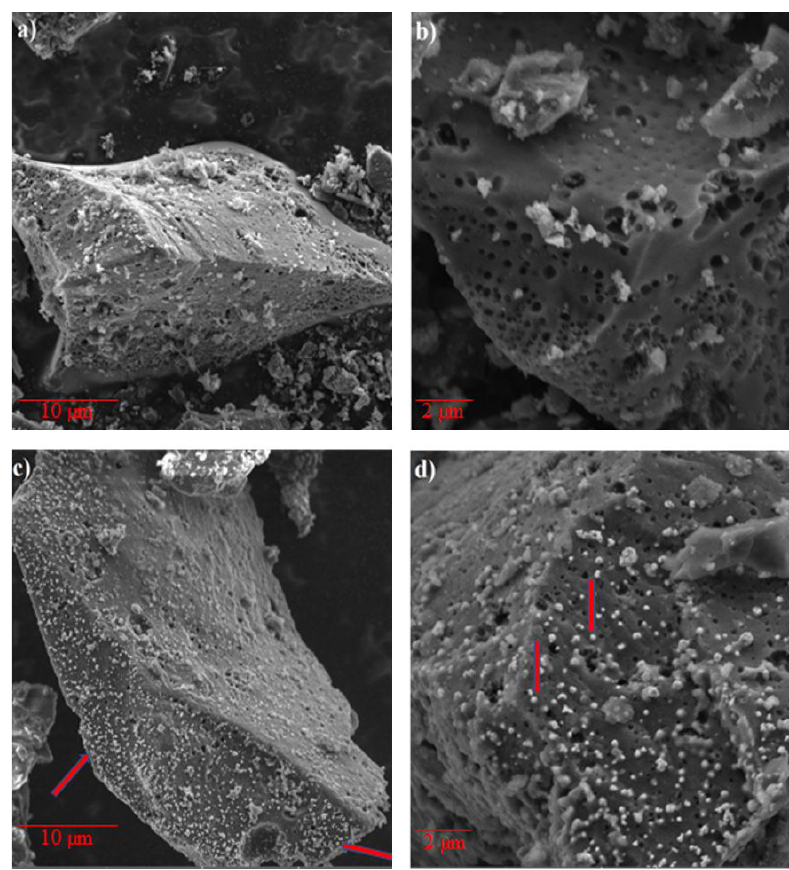
Figure 2. FEG-SEM images of the C matrix (a–b) and the C–Cu composite (c–d).